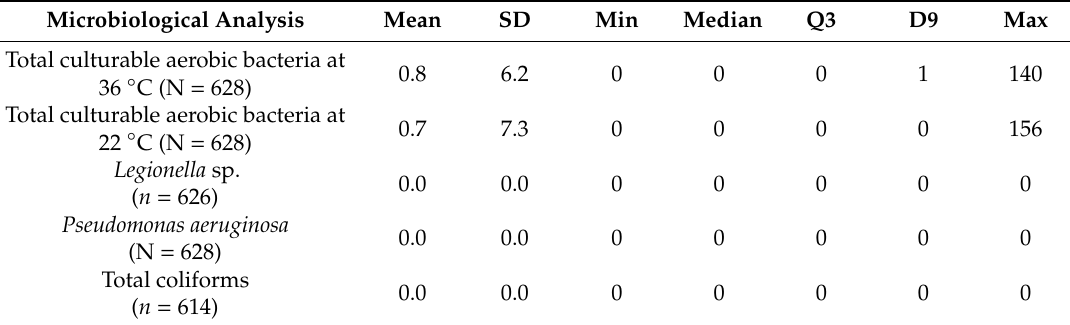
Table 2. Summary of six years microbiological water